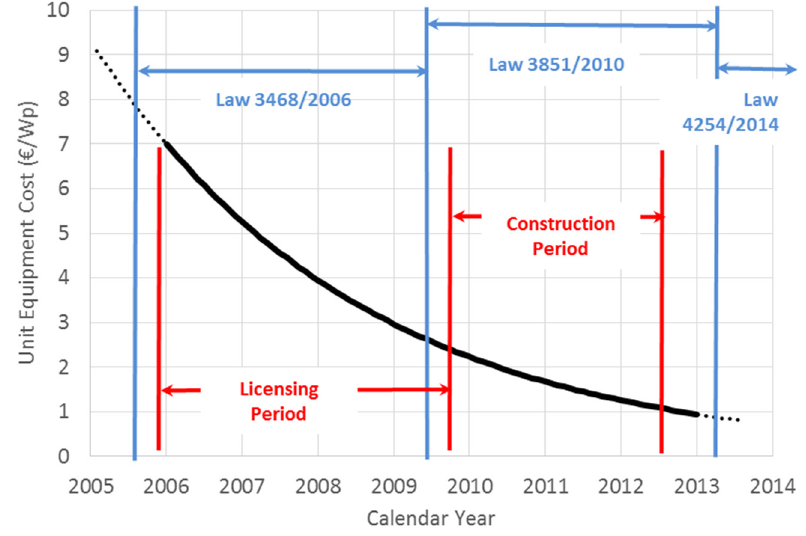
Figure 3. Evolution of Turn-Key Cost. Data from Hellenic Association of Photovoltaic Energy Producers